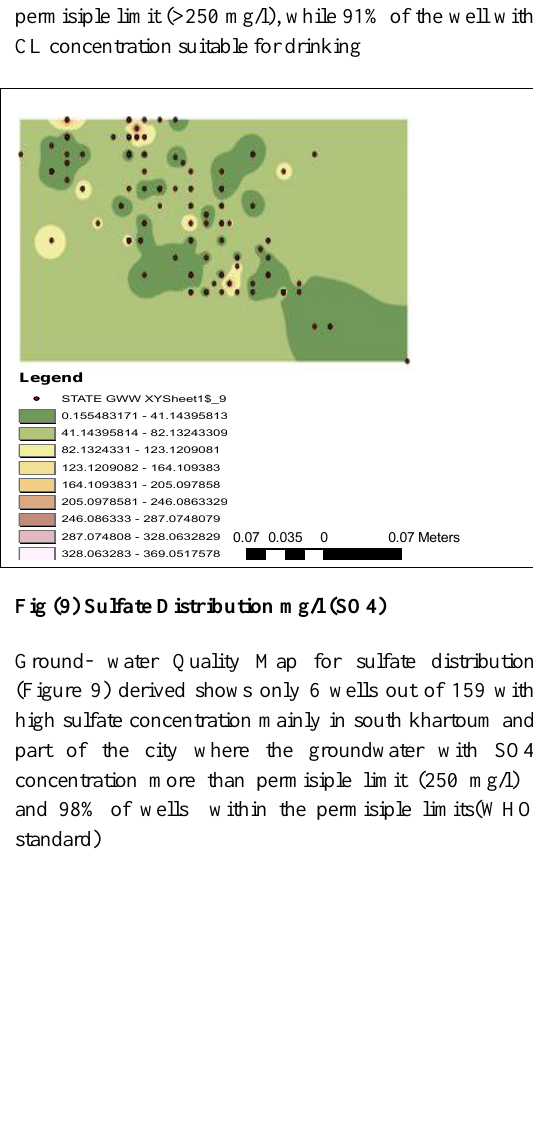
Fig (8)Chloride Distribution mg/l (CL) Water with high chloride content usually has an unpleasant taste and may be objectionable for some agricultural purposes.from the map we see there is 14 wells out of 159 with chloride concentration more than a permisiple limit (>250 mg/l), while 91% of the well with CL concentration suitable for drinking